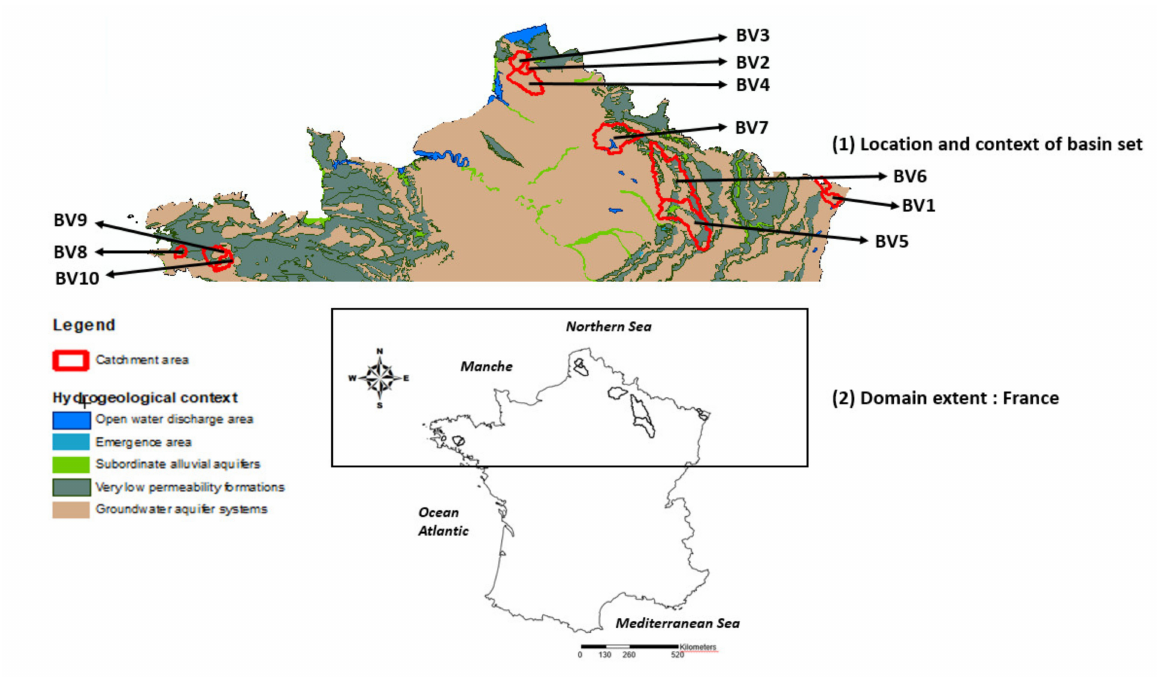
Figure 1. Location and hydrogeological context of the study’s 10